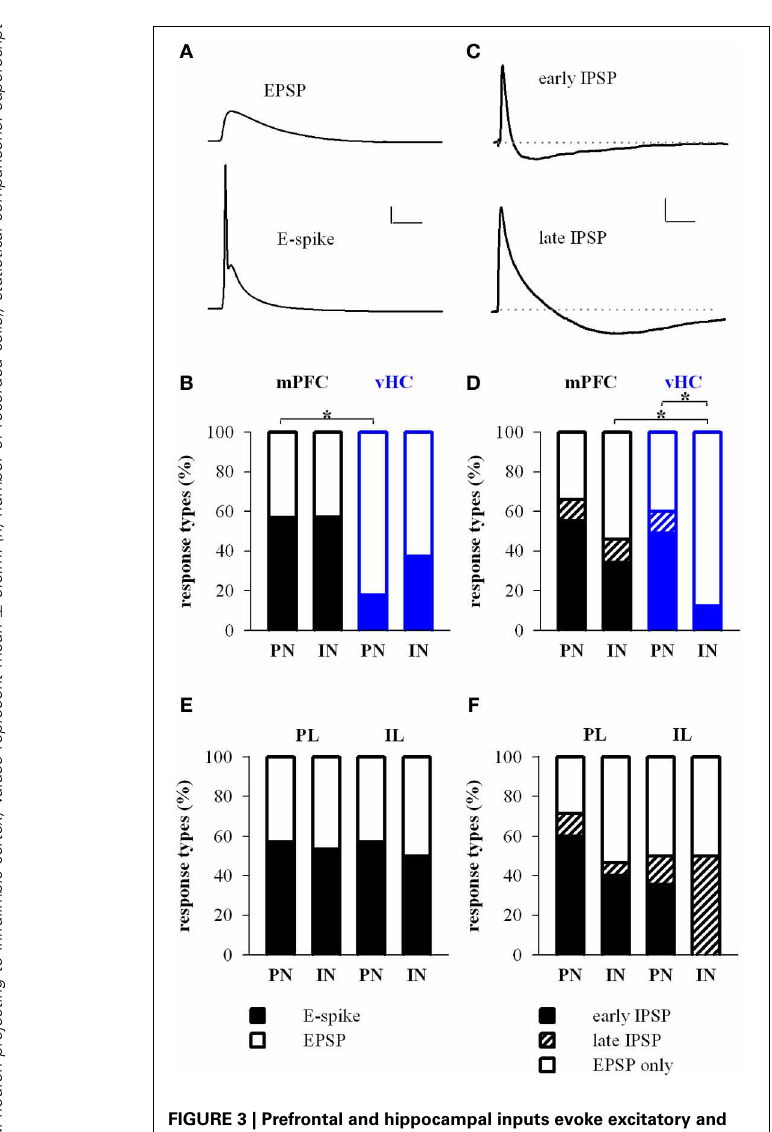
FIGURE 3 | Prefrontal and hippocampal inputs evoke excitatory and inhibitory responses in BA principal neurons and interneurons. (A) Example traces of excitatory response types showing subthreshold EPSP and EPSP-spike (E-spike) responses. Scale bar: 10mV/25ms. (B) Relative distribution (%) of excitatory response types in principal neurons (PN) and . ue s interneurons (IN) receiving synaptic inputs from mPFC (black) and vHC l (blue). Legend for (B,E) is shown in panel (E) . Spikes were more readily elicited in PNs by mPFC inputs than vHC inputs (Relative occurrence of spikes was for mPFC → PN: E-spike 57%, n = 65 vs. vHC → PN: E-spike 18%, n = 45; Fisher’s Exact Test, ∗ p < 0 . 001). No difference was observed in INs with mPFC and vHC inputs (mPFC → IN: E-spike 57%, n = 35 vs. vHCI → N: E-spike 38%, n = 16; Fisher’s Exact Test, p = 0 . 237) or INs vs. PNs within each input type (Fisher’s Exact Test, p = 1 for mPFC and p = 0 . 164 for vHC). (C) Example traces showing early and late inhibitory response types. Scale bar: 2mV/50ms. (D) Relative distribution (%) of purely excitatory (open bars) and additional inhibitory response types (early IPSP: closed bars, late IPSP: striped bars) in PNs and INs receiving input from mPFC and vHC. Legend for (D,F) is shown in panel (F) . Occurrence of inhibitory response types for mPFC → PN: early 55%, late 11%, n = 65; mPFC → IN: early 34%, late 11%, n = 35; vHC → PN: early 49%, late 11%, n = 45; and vHC → IN: early 12%, n = 16. Inputs from vHC recruited